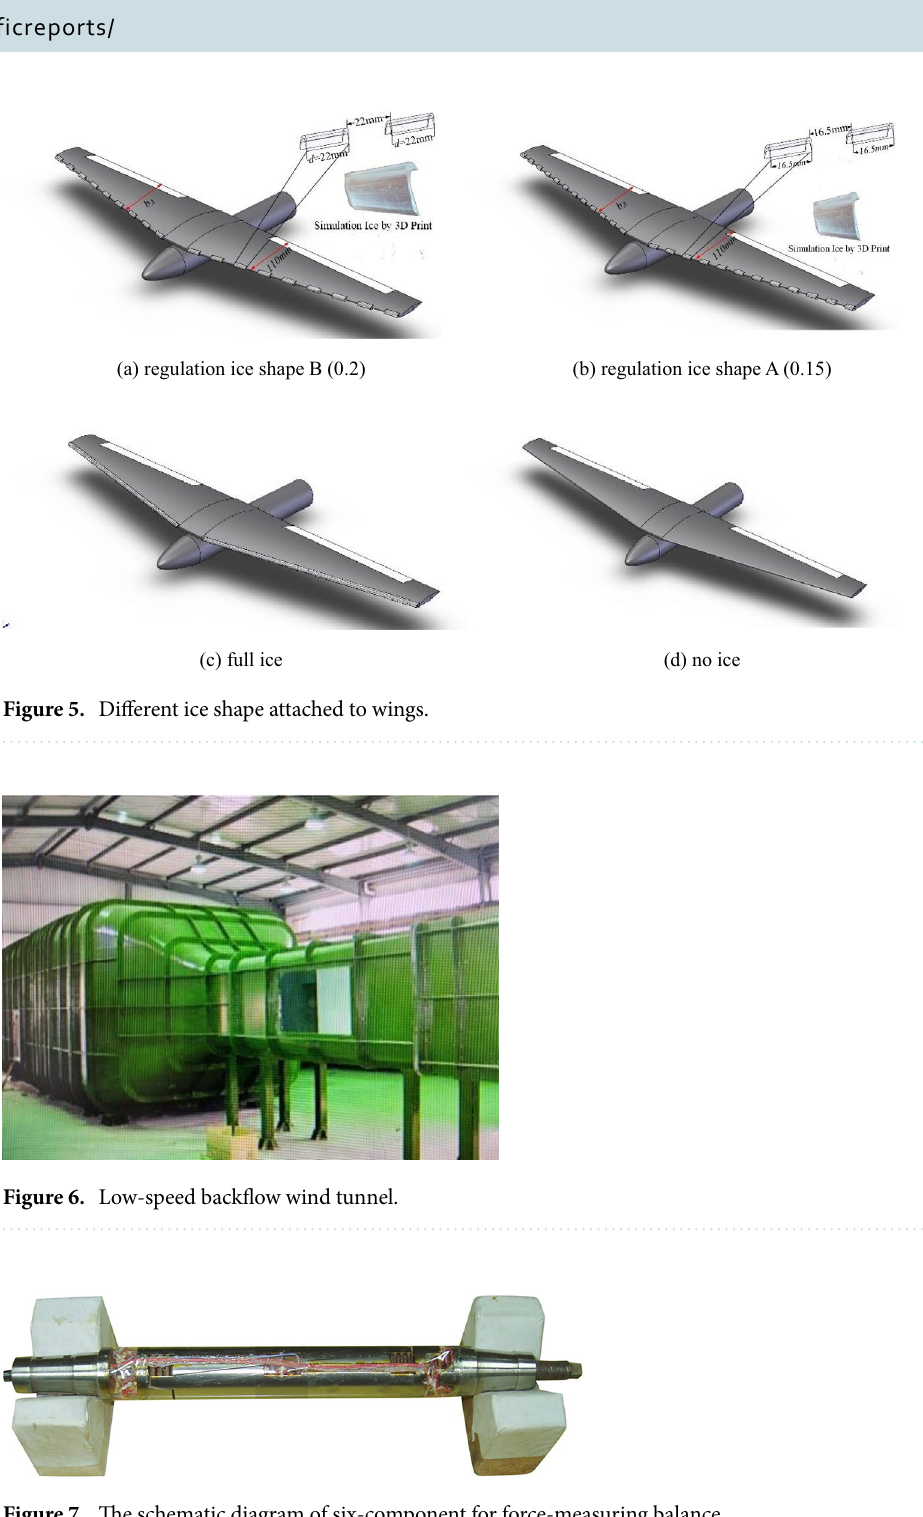
Figure 7. The schematic diagram of six-component for force-measuring